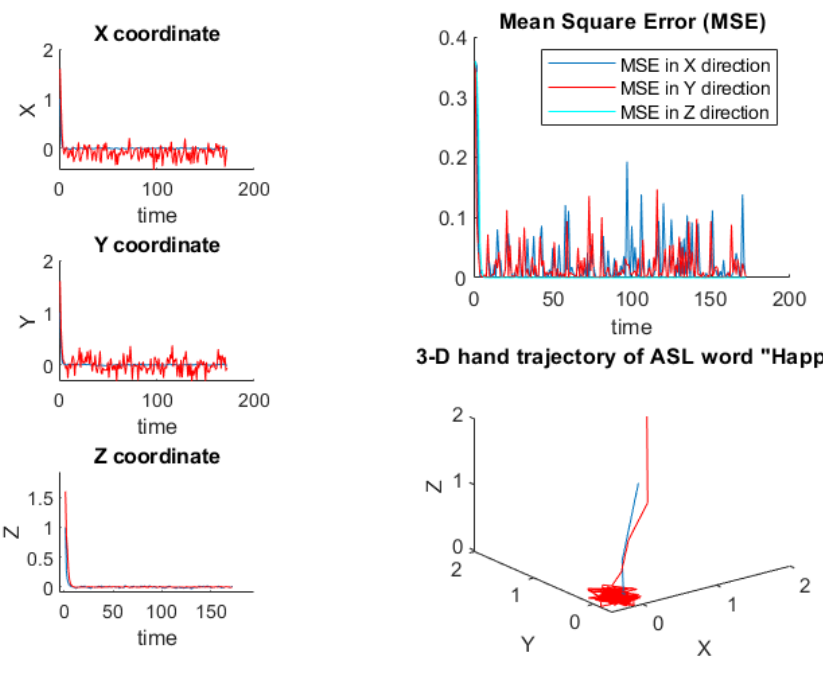
Figure 3. 3D Hand motion trajectories across video frames using